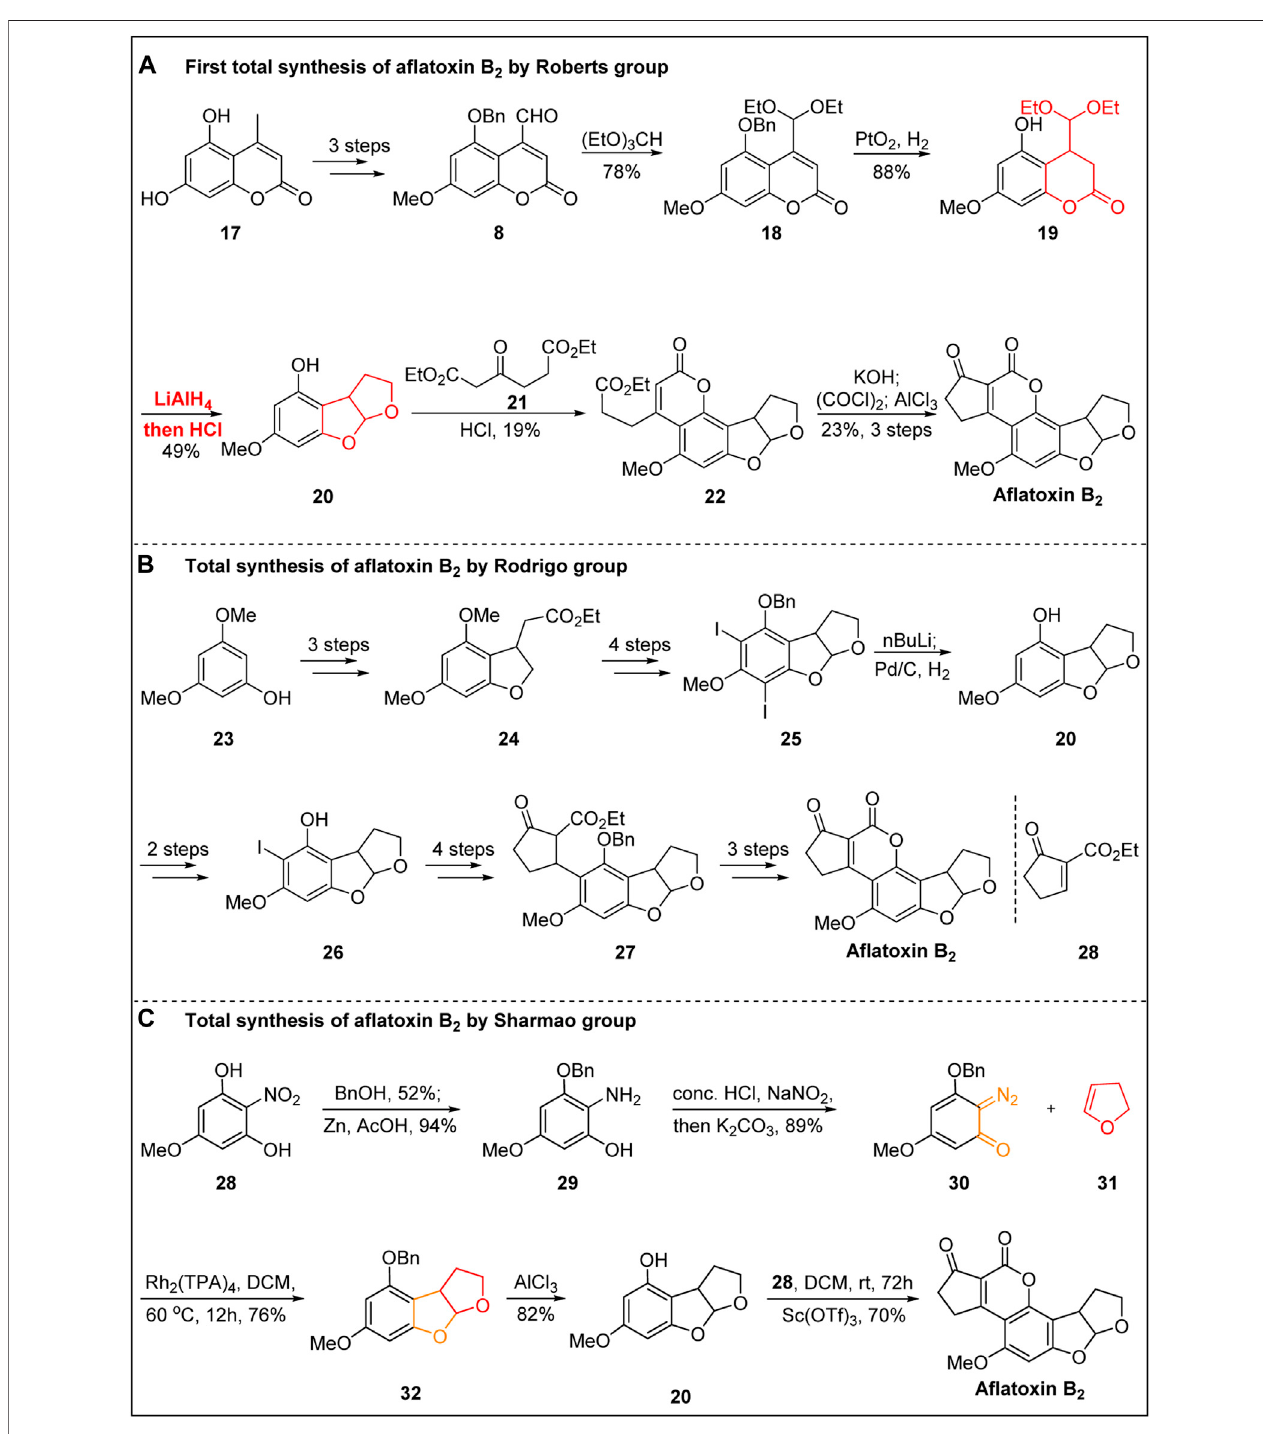
FIGURE 3 | Total synthesis of ( ± )-a fl atoxin B